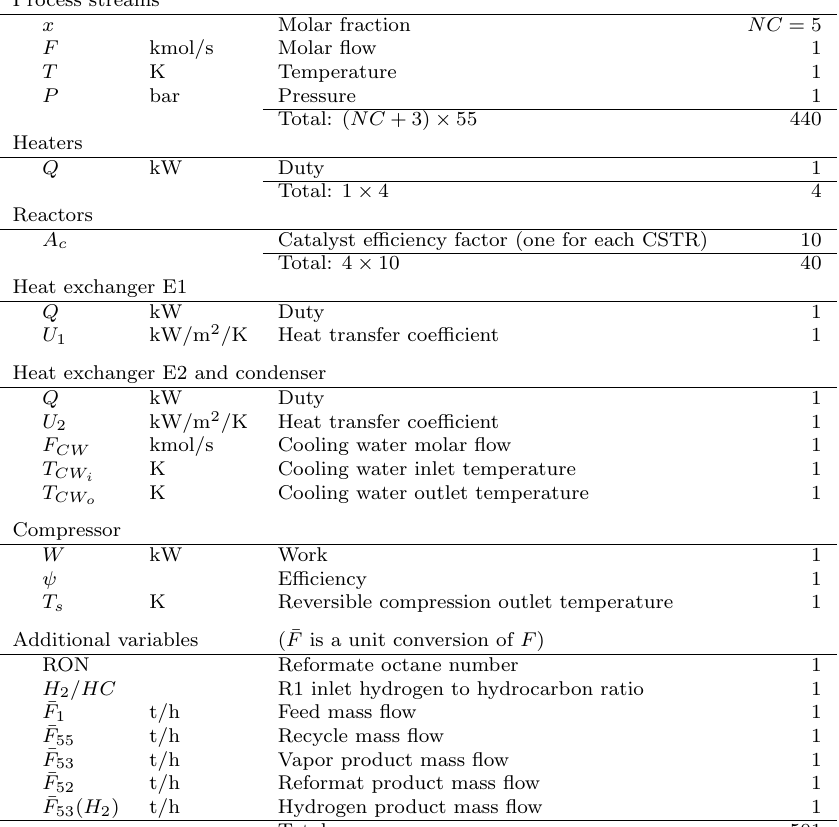
Table 1: Reformer model variables